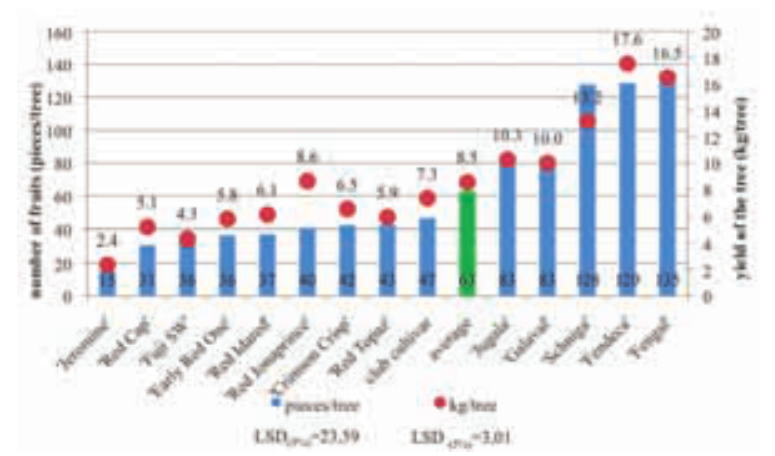
Figure 6: Yields per tree of apple cultivars (pieces/tree, kg/tree) (Nyírbátor, 2013)